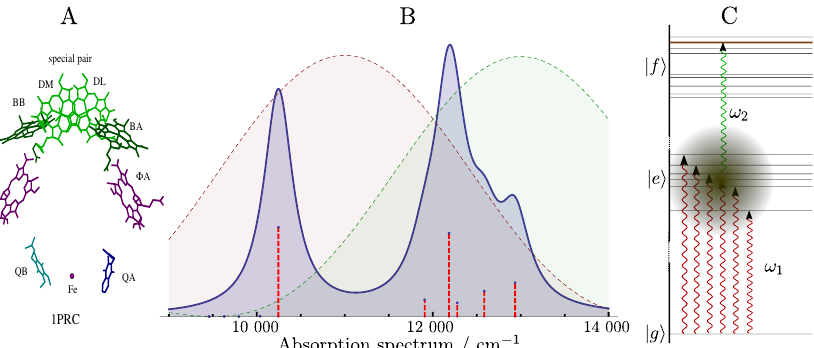
Fig. 1. A: The bacterial reaction center (PDB code: 1PRC). B: The linear absorption spectrum (blue) as well as the power spectrum of two entangled beams (red & blue dashed) with central frequencies ω 1 = 11 000 and ω 2 = 13 000 cm − 1 . The exciton states are marked by dashed vertical lines whose height is proportional to their dipole moments. C: The broadband entangled beams allow to explore all pathways leading to a doubly-excited state through the single-exciton